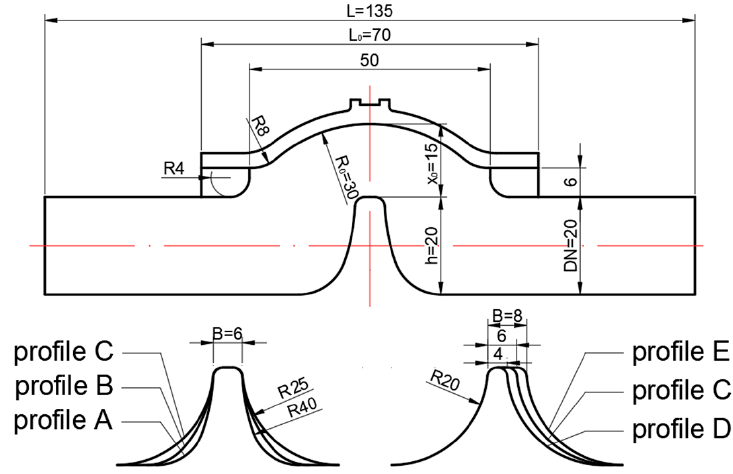
Table 1. Liquidlens TM LLG4 System Flow Parameter Index.